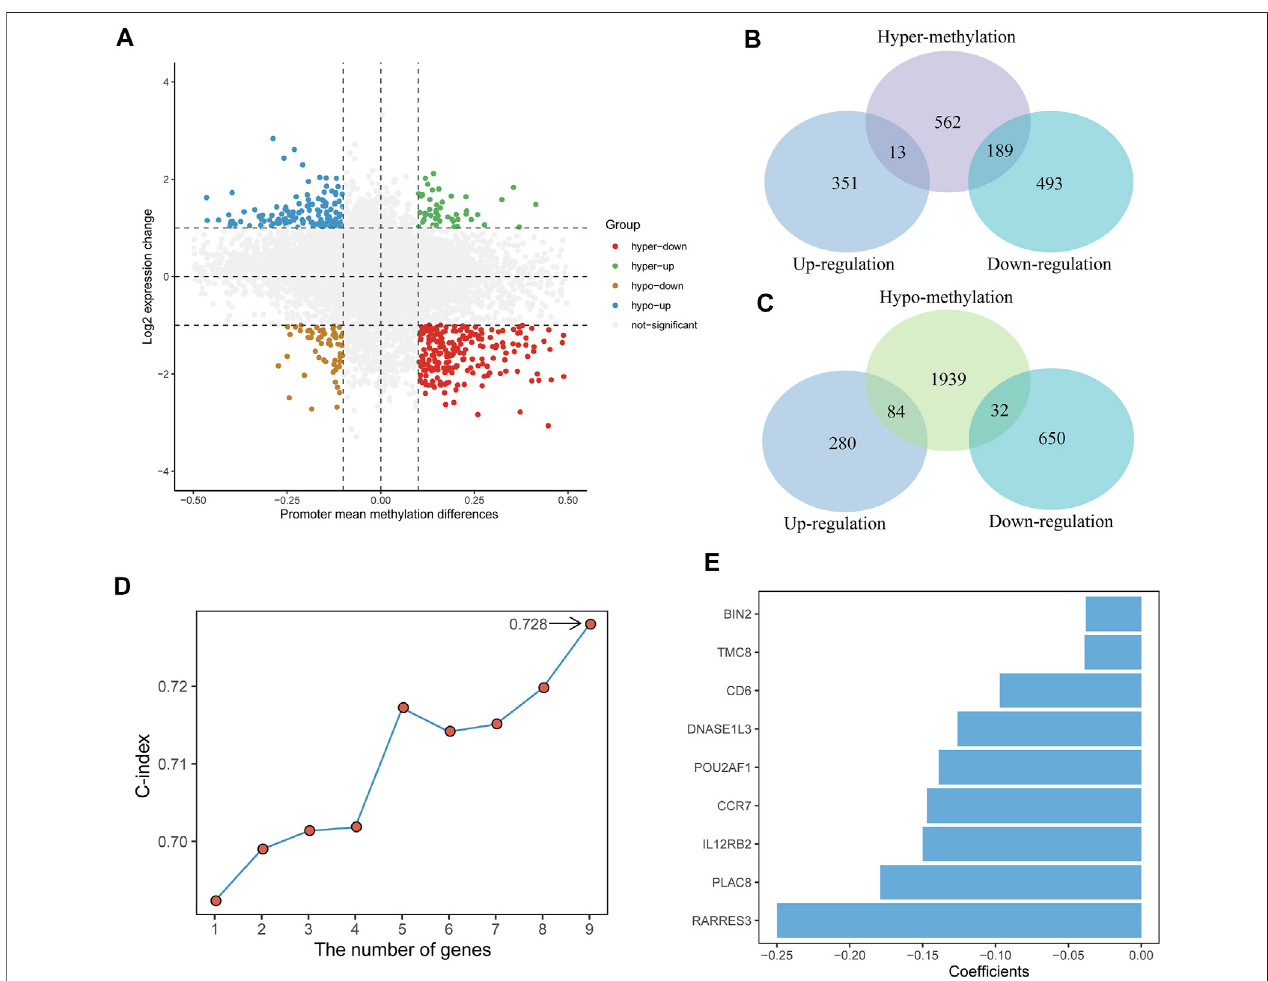
FIGURE 1 | Identi fi cation of the TME and DNA methylation-related prognostic signature. (A) Scatter plot of promoter mean methylation difference and gene expression levels change. hyper-up, hypermethylated-upregulated; hyper-down, hypermethylated-downregulated; hypo-up, hypomethylated-upregulated; hypo- down, hypomethylated-downregulated. (B,C) Venn diagrams showing the intersection between DEGs and hypermethylated genes (top) and between DEGs and hypomethylated genes (bottom). (D) The C-index of different genes combinations in the signature. (E) The nine genes included in the signature. Corresponding coef fi cients are depicted by horizontal